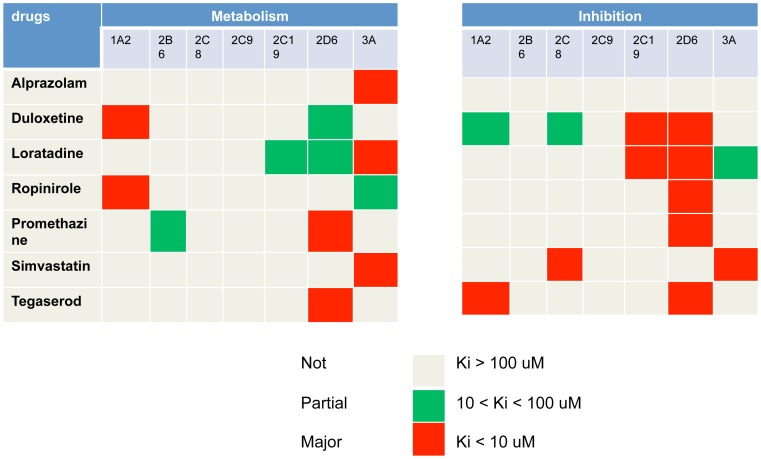
Metabolism enzymes and inhibition potencies of seven drugs.The metabolism enzymes of a drug are characterized with major, partial, or not. The inhibition potencies of a drug are characterized with strong (Ki<10 uM), moderate (10<Ki<100 uM), and weak (Ki>100 uM).